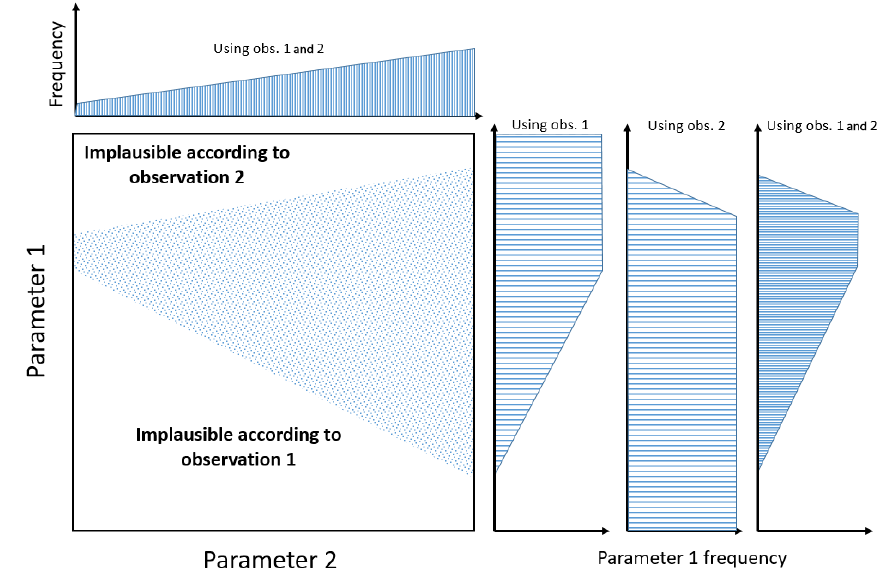
Figure 5. Schematic of parameter constraint in two dimensions using two measurements.